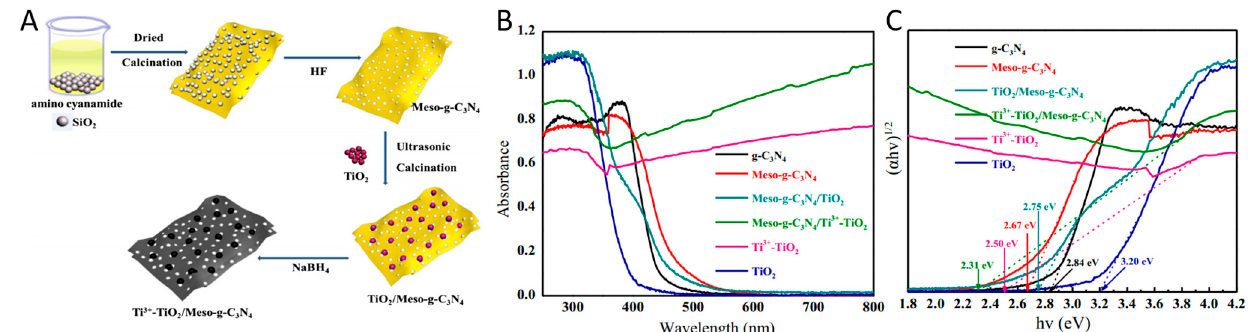
Figure 12. ( A )The synthetic process of Ti 3+ -TiO 2 /g-C 3 N 4 nanosheets heterojunctions; ( B ) UV-vis diffuse reflectance spectra; ( C ) the corresponding calculated band gaps. Reprinted with permission for ref. [118]. Copyright 2018, Elsevier.